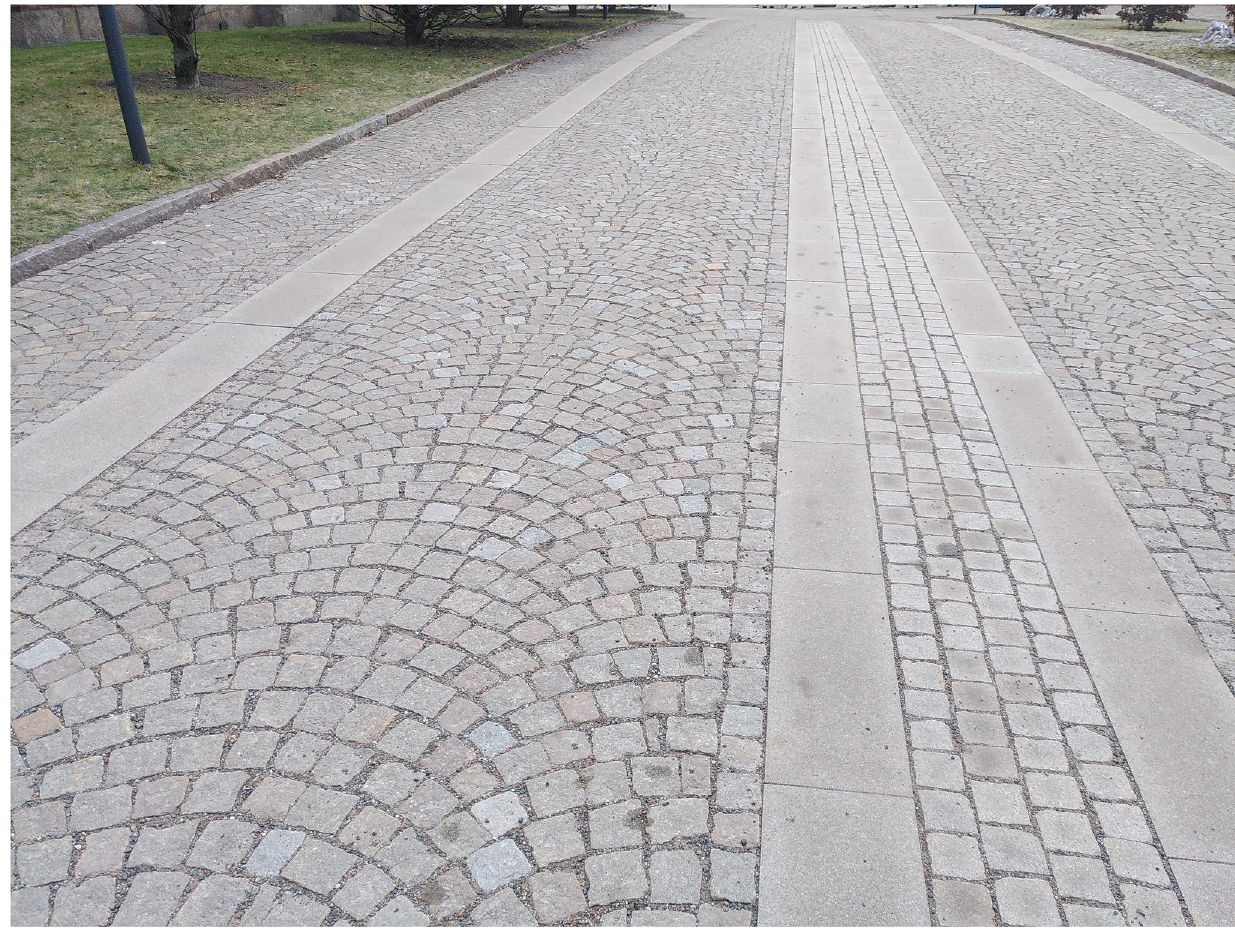
Fig 2. Cobblestone road surface for outdoor tests. The tests were carried out between the concrete slabs.